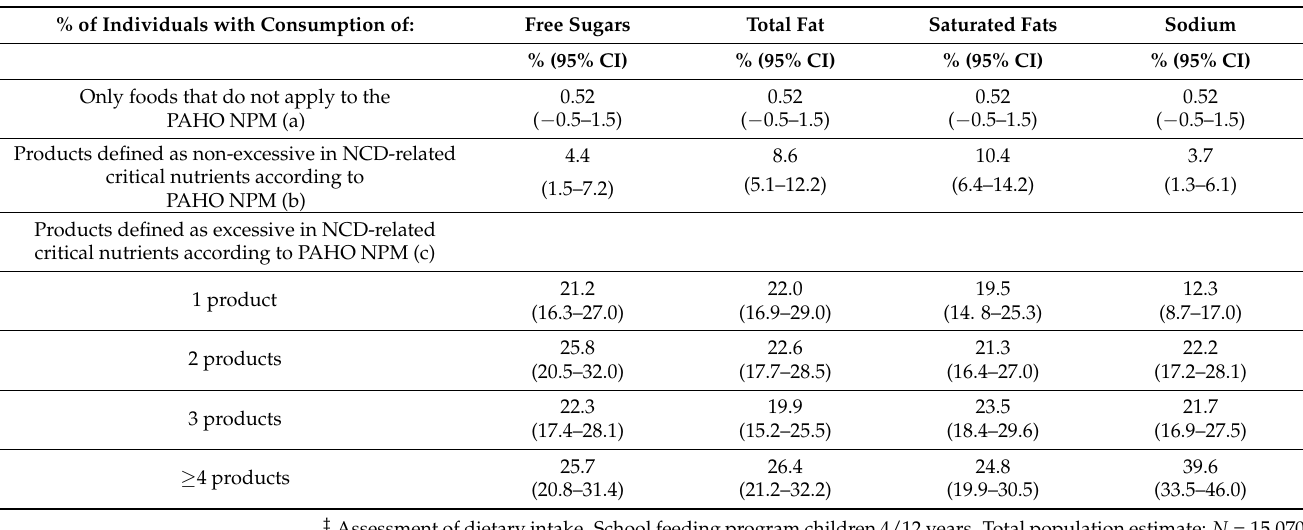
Table 1. Consumption of products defined as excessive in NCD-related critical nutrients according to PAHO-NPM ‡ .